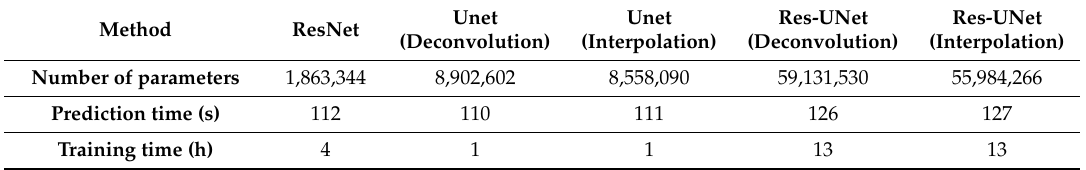
Table 5. Parameters, training, and prediction time of different classification methods.